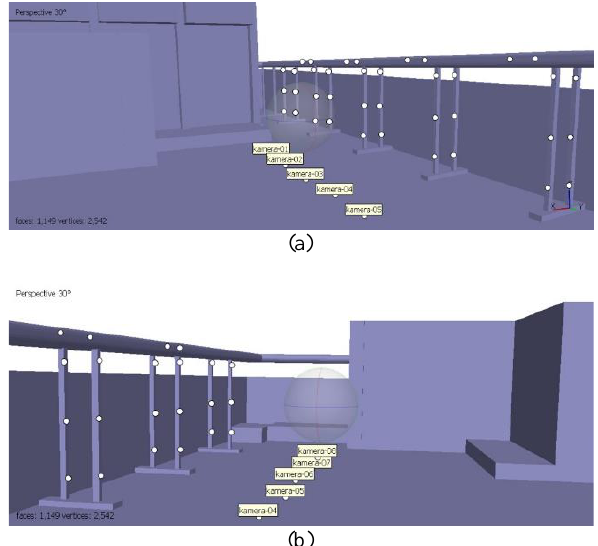
Figure 4. The location of target points and camera station points as generated from the simulation process from (a) right side and (b) left side